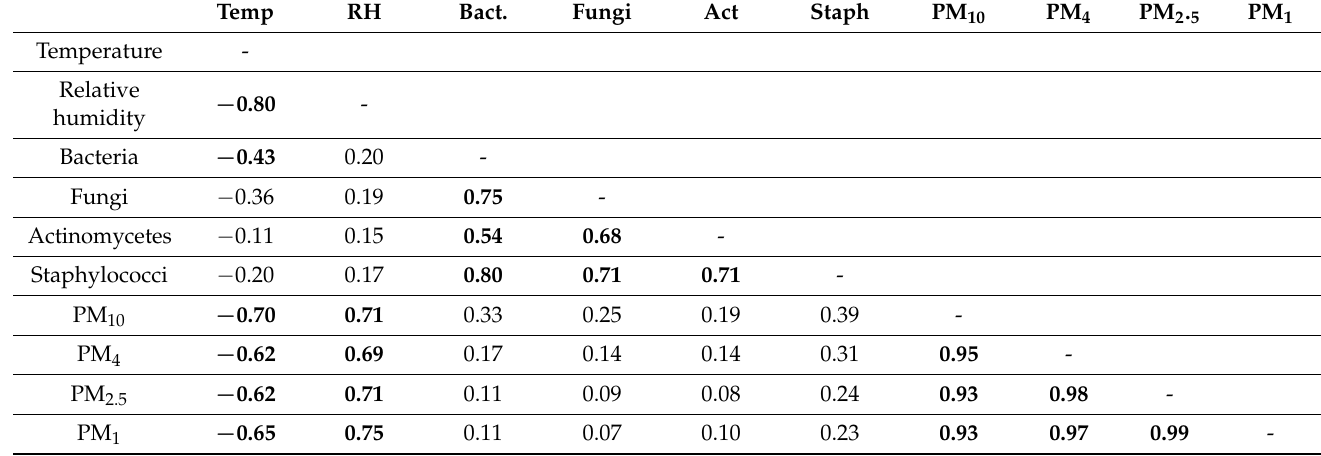
Table 3. Spearman’s correlation coefficient matrix for microbial bioaerosol components, PM fractions, temperature and relative humidity of air. Bolded values are significant at p < 0.05.